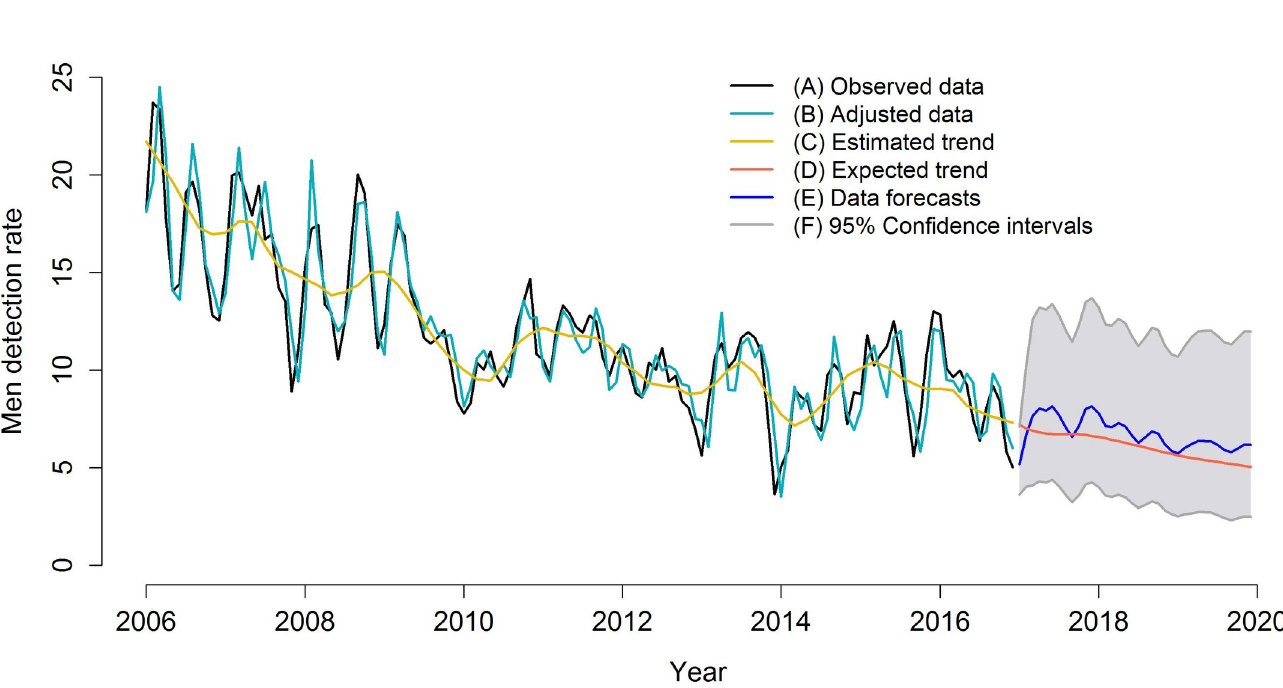
Fig 6. SARIMA model (9,1,0) (1,0,0) 12 adjusted for leprosy detection rates among men (2006–2016) and forecast of leprosy detection rates among men (2017–2020), Imperatriz, MA, Brazil (2006–2016). (A) Observed data; (B) Adjusted data; (C) Estimated trend; (D) Expected trend; (E) Data forecasts; (F) 95% Confidence